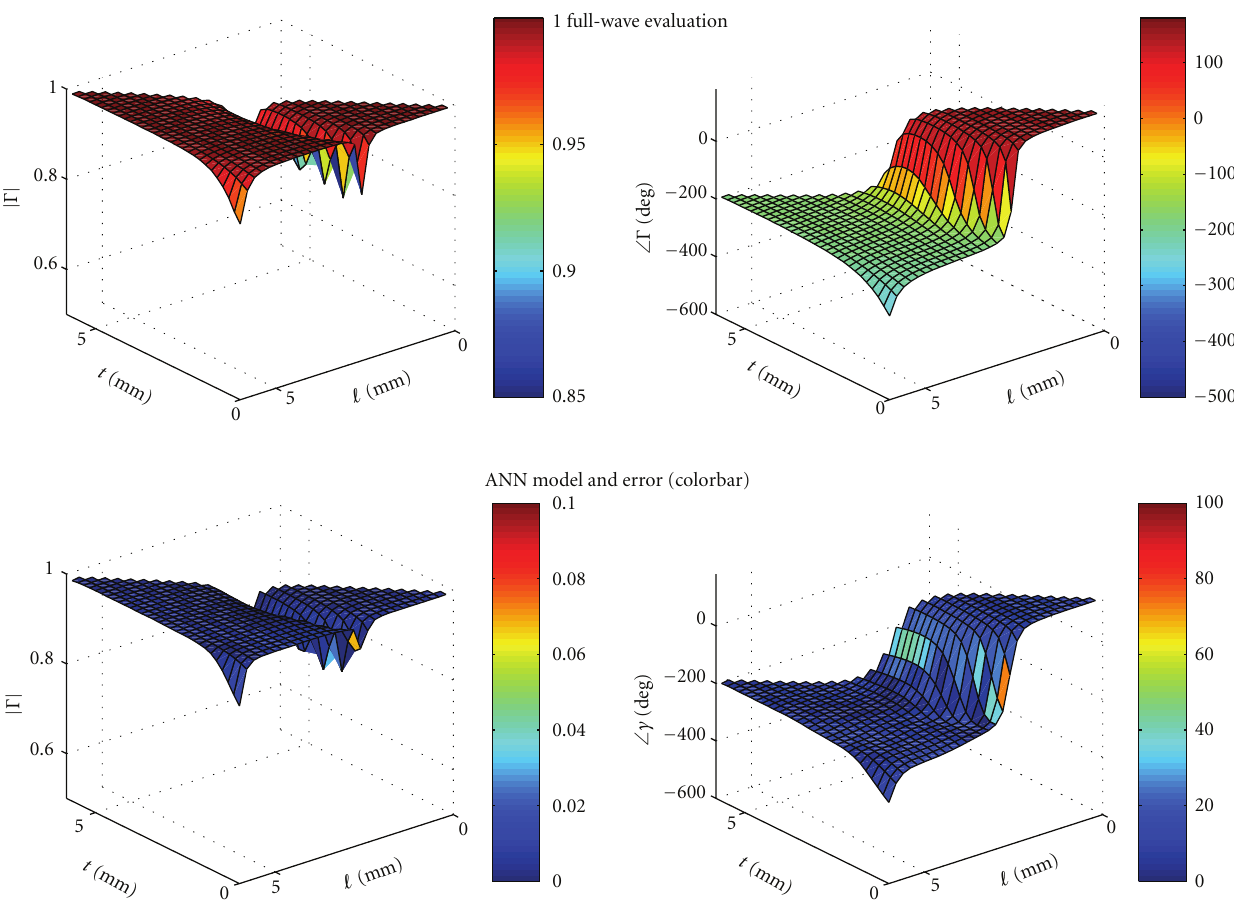
Figure 6: Reflection coe ffi cient amplitude (left) and phase (bottom) versus the two RA geometrical parameters (cid:2) and t of the modified Malta Cross, computed with direct full-wave (top) and reconstructed with the ANN (bottom). f = 10 . 7 GHz, θ inc = 65 ◦